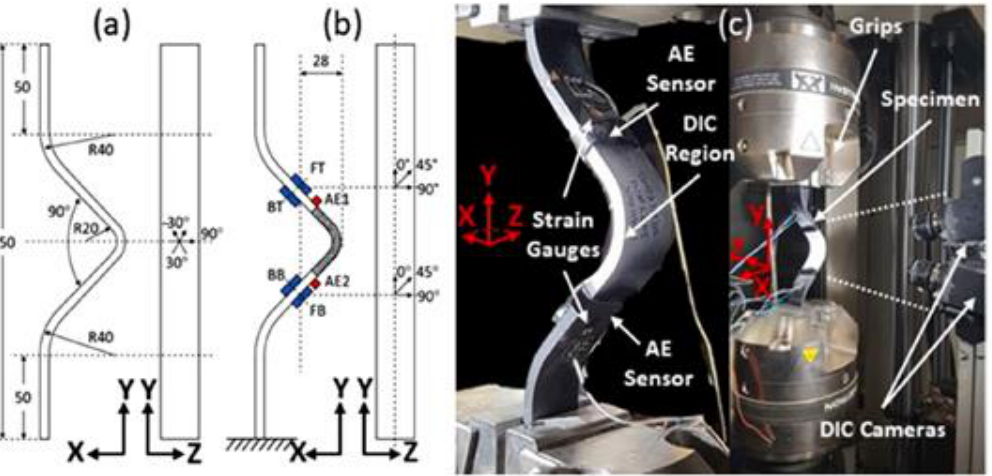
Figure 2. ( a ) Geometry of the V-shape specimens, ( b ) position of acoustic sensors and strain gauges, and ( c ) overview of the test setup [9].